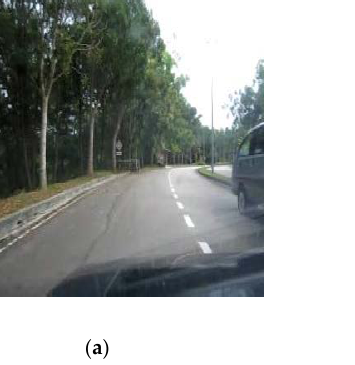
Figure 17. Autonomous detection and navigation of the proposed system in the road following (with 5 m as width and 500 m as length) with partial car on the side: ( a ) original image, ( b ) image processing, and ( c ) generation of the path within the road following environment.